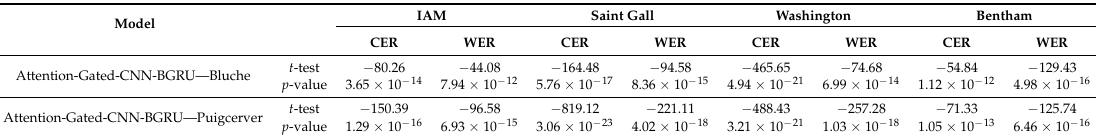
Table 8. A comparison of the recall (i.e., sensitivity) of the CER, WER, and SER for test dataset on (IAM, Saint Gall, Washington, and Bentham). To verify whether our proposed model achieves statistically significant improvements in the sensitivity of reducing the errors, the paired t -test is conducted with the confidence of 95% ( p -value <